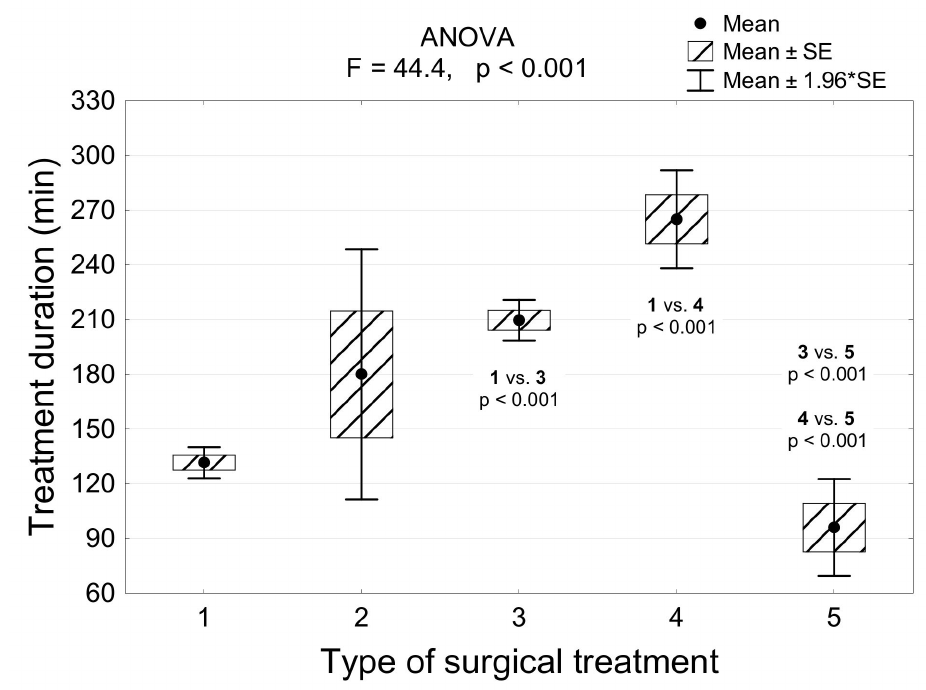
Figure 9. The duration of treatment in the groups of patients differing in the type of treatment and the results of the analysis of variance (ANOVA) and post-hoc Tukey